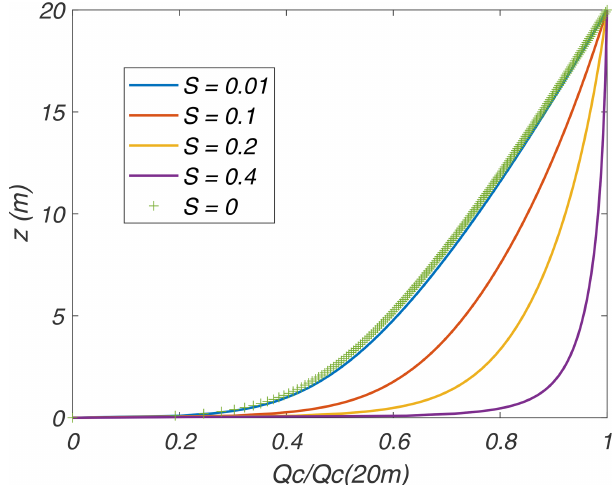
Figure 4. Qc / Qc(ztop) profiles with stable stratification, assuming (cid:56) Qc ( z/L ) = 1 + β ( z + z 0c ) /L . We set β = 5, L = 20m and z 0c = 0 .